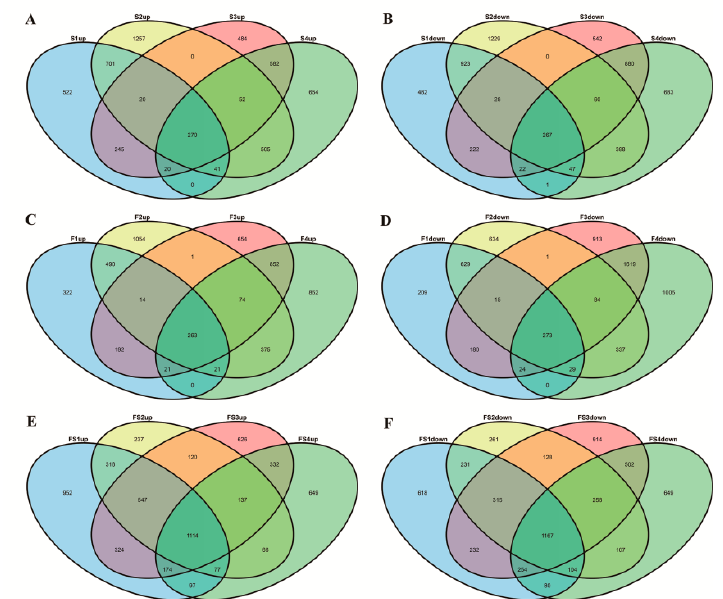
Figure 2. Differential expressed genes in high-TPC lines compared to low-TPC lines, according to RNA sequencing (RNA-seq). ( A ) Up-regulated differentially expressed genes (DEGs) between high- and low-TPC lines in the stem apex; ( B ) down-regulated DEGs between high- and low-TPC lines in the stem apex; ( C ) up-regulated DEGs between high- and low-TPC lines in the flower bud; ( D ) down-regulated DEGs between high- and low-TPC lines in the flower bud; ( E ) up-regulated consistently genes between stem apex and flower bud in the high- and low-TPC lines; ( F ) down-regulated consistently genes between stem apex and flower bud in the high- and low-TPC lines. S1, S2, S3, and S4 indicate the comparison results of YC4 – YC11, YC4 – YC15, YC33 – YC11, and YC33 – YC15 in the stem apex, respectively; F1, F2, F3, and F4 indicate the comparison results of YC4 – YC11, YC4 – YC15, YC33 – YC11,